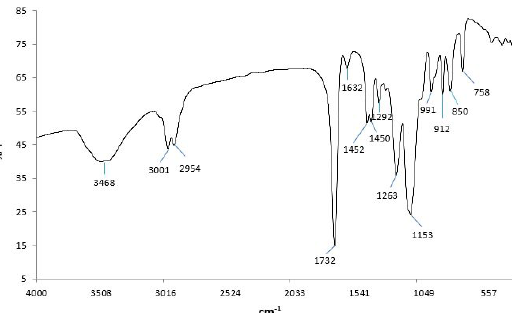
Figure 2. FT-IR spectra of P-01